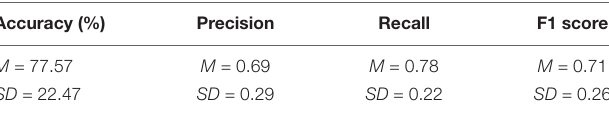
TABLE 6 | Mean (M) and standard (SD) deviation of accuracy, precision, recall, and F1 score of logistic regression classifier for differentiating among AF, AM, and EM